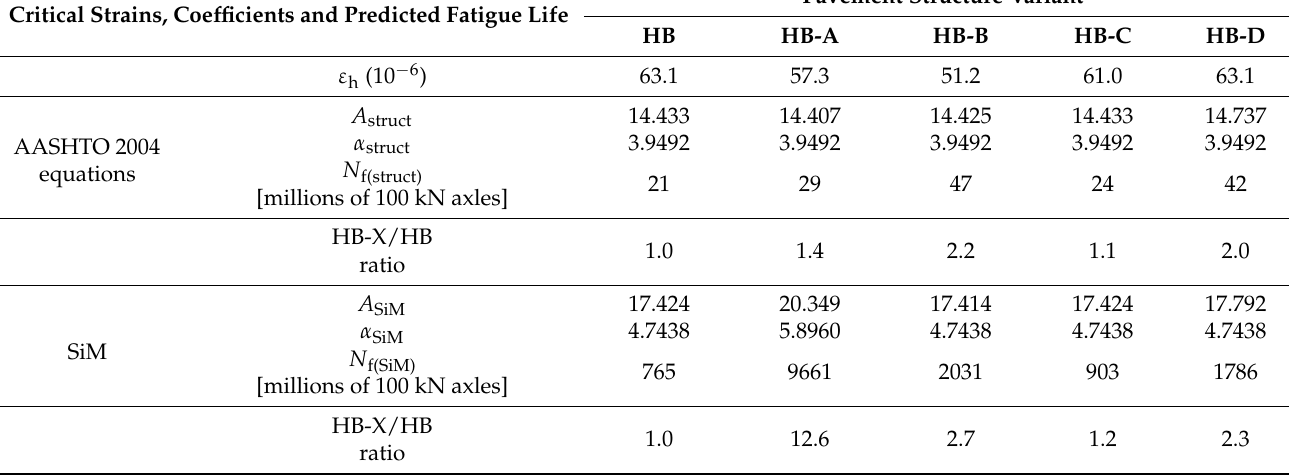
Table 9. Results of application of the SiM method and the AASHTO method (as a reference) for selected modifications of the HB pavement